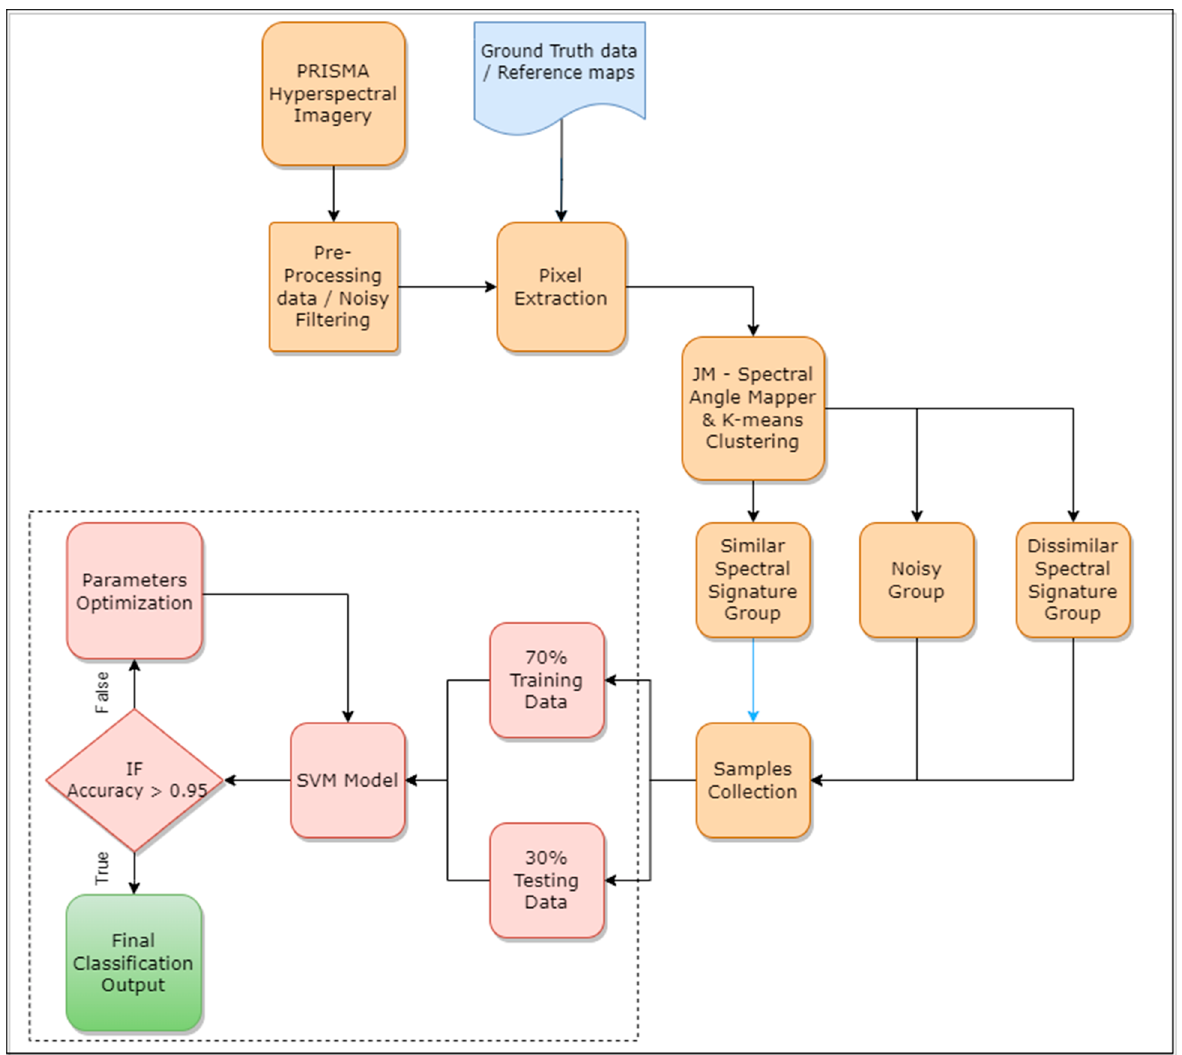
Figure 4. Stepwise flowchart of machine learning-based vegetation classification using PRISMA hyperspectral imagery.